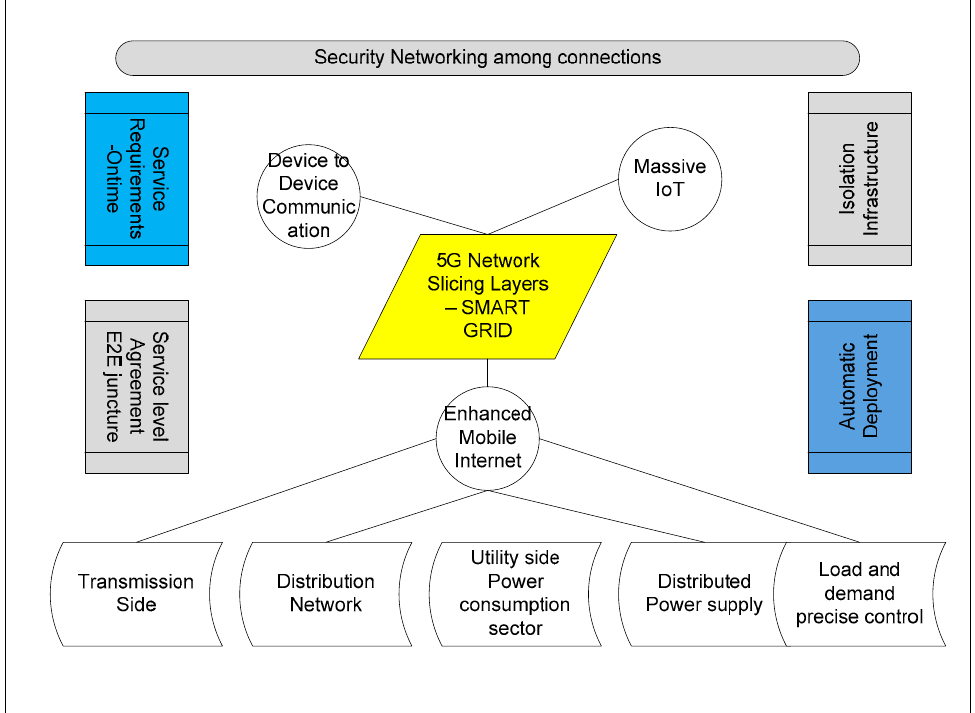
Figure 3. Roadmap architecture of 5G and smart grids.